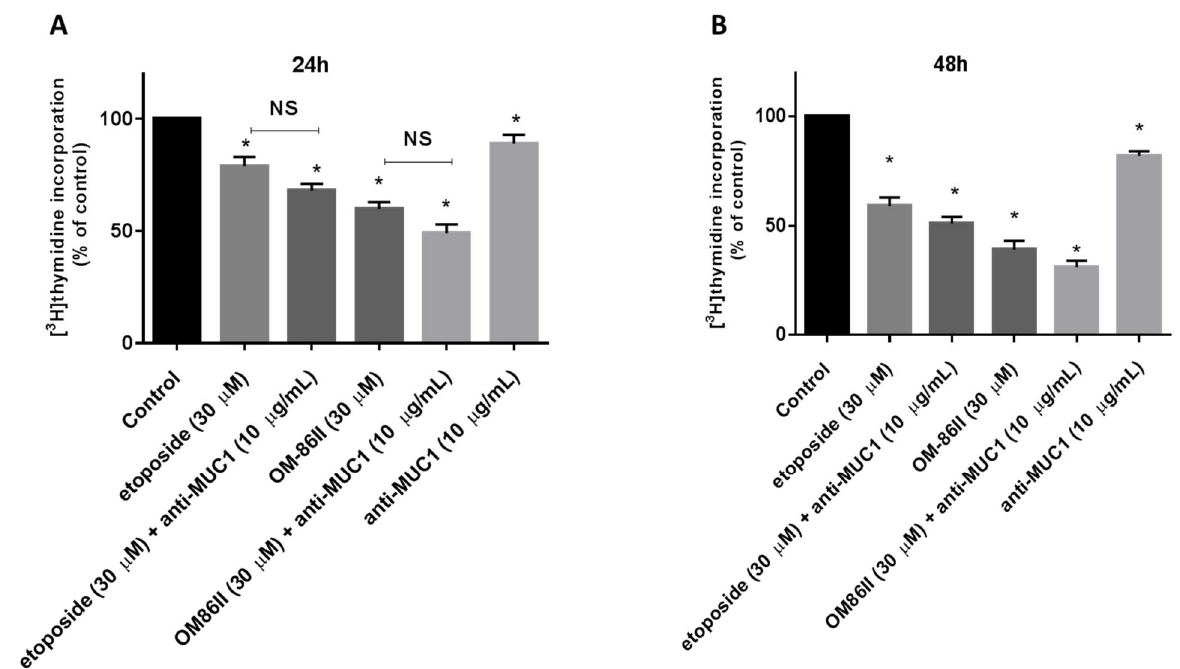
Figure 2. The effect of anti-MUC1 (10 µg/mL), OM-86II (30 µM), OM-86II + anti-MUC1 (30 µM + 10 µg/mL), etoposide (30 µM) and etoposide + anti-MUC1 (30 µM + 10 µg/mL) on DNA biosynthesis in cultured AGS cells after 24 h ( A ) and 48 h ( B ) of incubation, as measured by inhibition of [ 3 H]-thymidine incorporation into DNA. Mean ± SD from three independent experiments ( n = 3), performed in duplicate, are presented. * p < 0.05 vs. control group; MUC1, mucin-1; OM-86II, octahydropyrazin[2,1-a:5,4-a′]diisoquinoline derivative; ns, not significant.